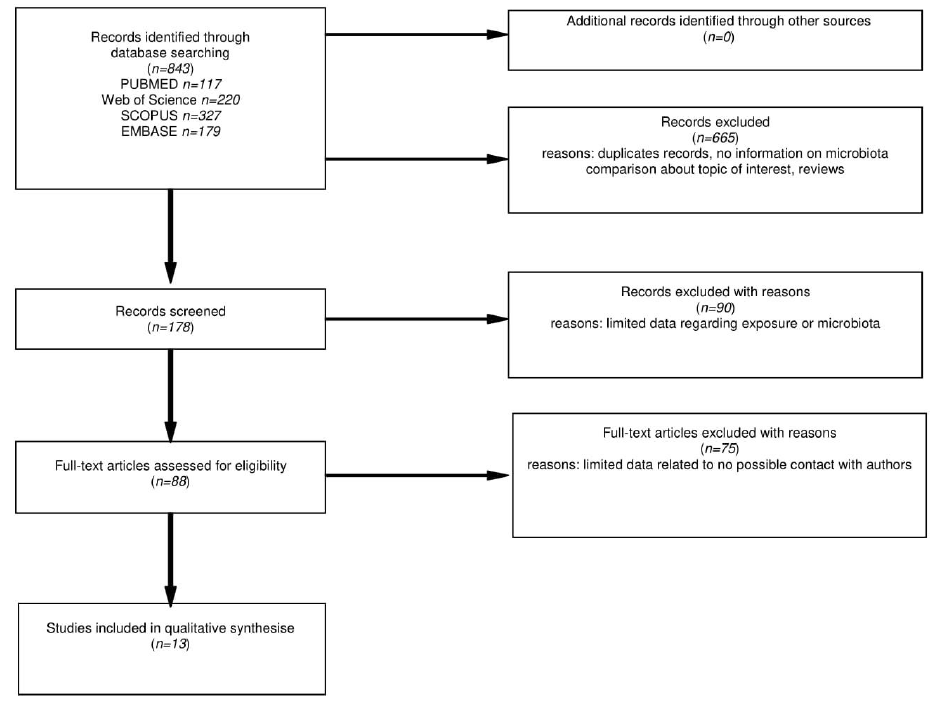
Figure 1. Flow chart of the databases search on microbiota changes in CD patients on GFD.